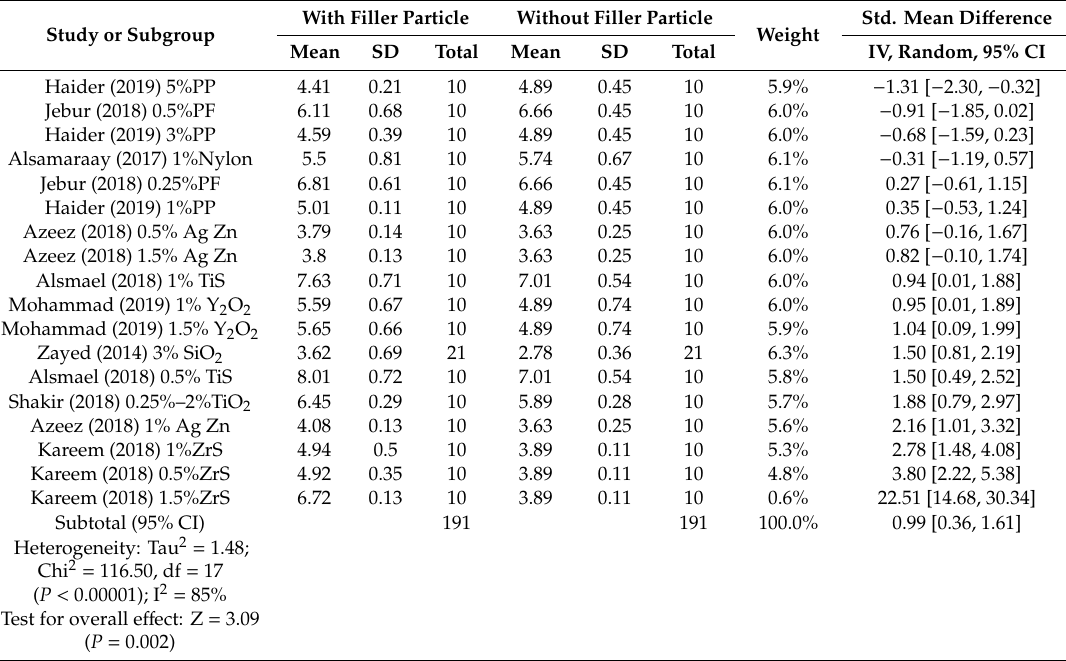
Table 3. Summary findings and forest plot of tensile strength (MPa) outcomes in case-control studies incorporating filler particles with MFPSE.